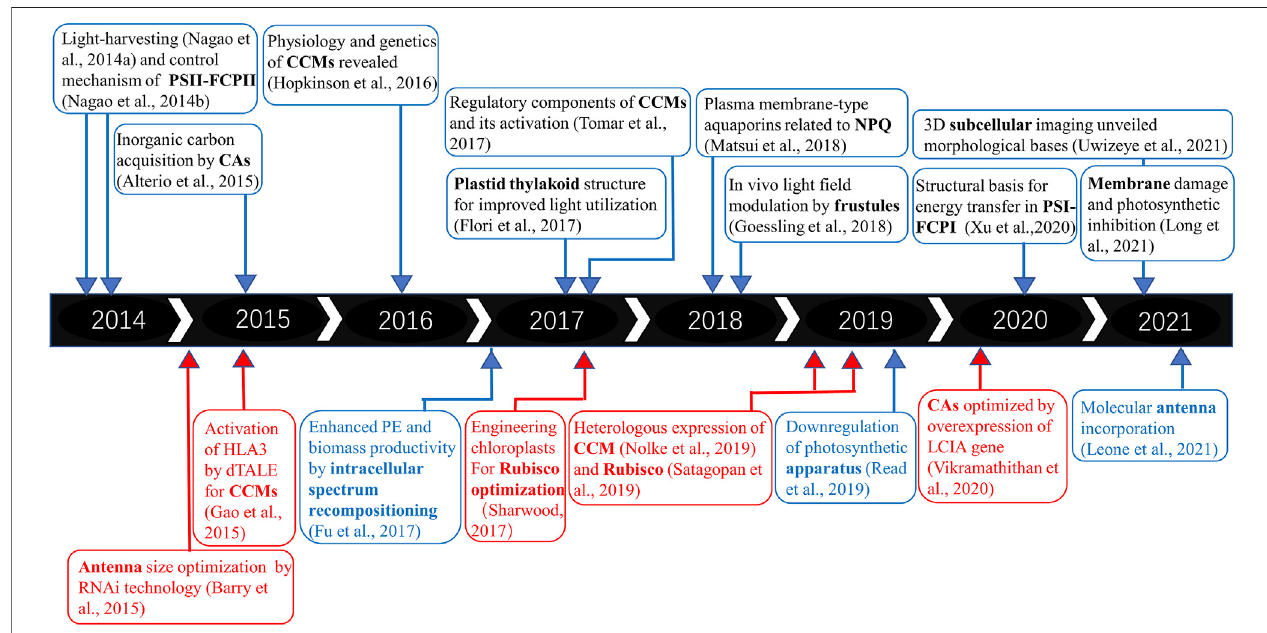
FIGURE 1 | Timeline and basic and applied research trends on microalgal PE and biomass productivity. The upper panel refers to fundamental research on PE in diatoms, and the lower panel refers to practical applications of synthetic biology tools. The red part represents green microalgae, while the blue region represents